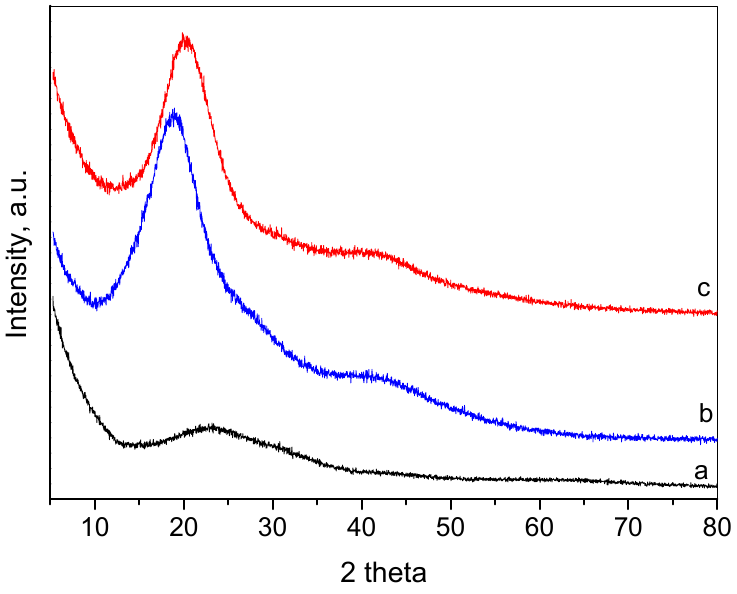
Figure 1. XRD patterns of empty chitosan–alginate nanoparticles ( a ), oregano oil ( b ), and oregano oil ‐ loaded chitosan–alginate nanoparticles ( c ).